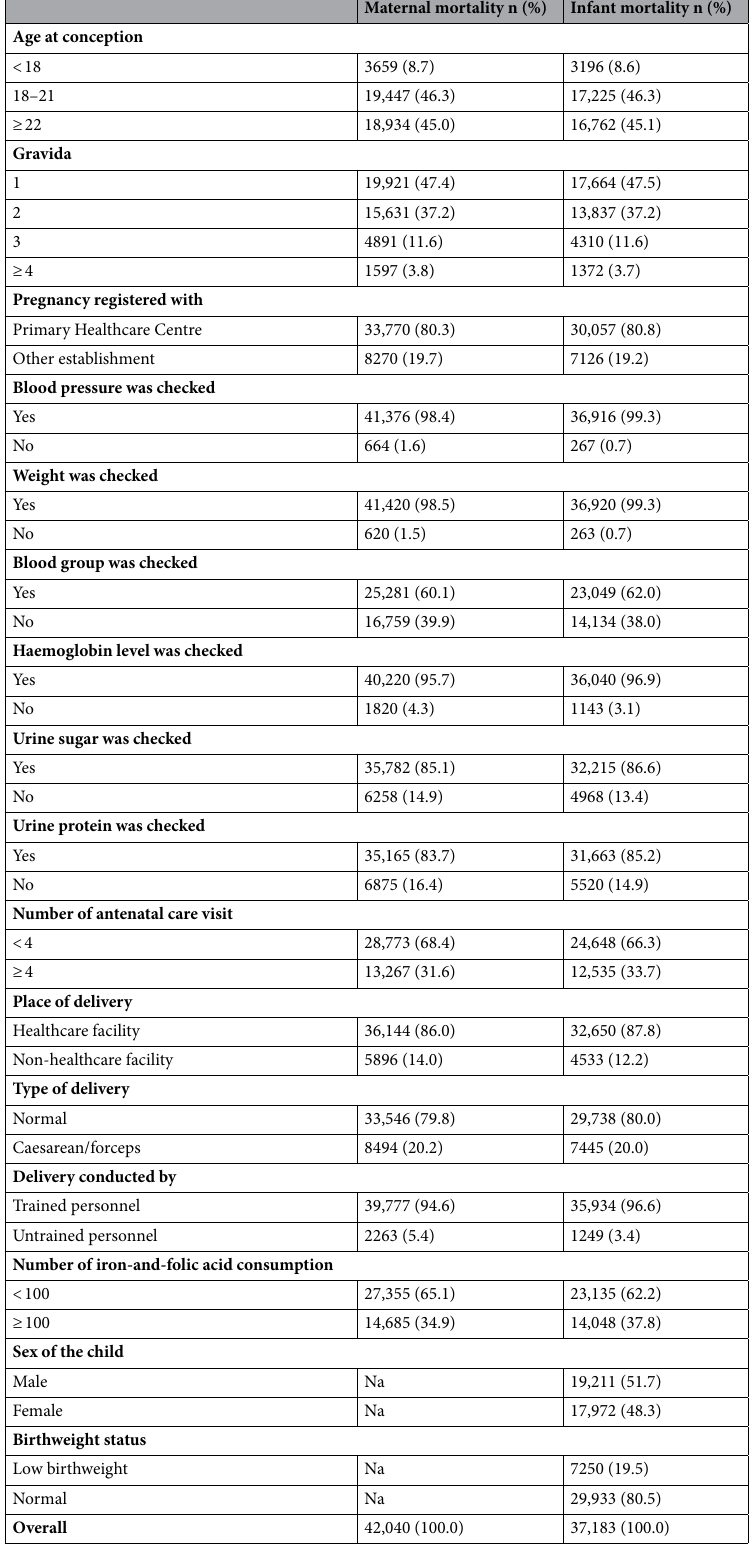
Table 1. Sample distribution of total pregnancies used to measure maternal and infant mortality, by select background characteristics. Percentage distribution may not add to 100 due to rounding. n sample, na not